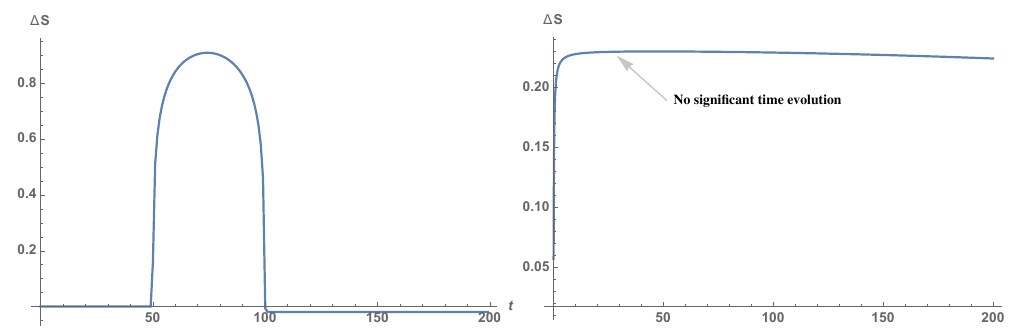
(0) Figure 8 . ∆ S after a single splitting quench in a Dirac free fermion CFT, where A = S A − S A is the EE of the vacuum state. A = [50 , 100] in the left figure and A = [0 . 1 , 1000] in the right S (0) A figure. We set a = 0 .